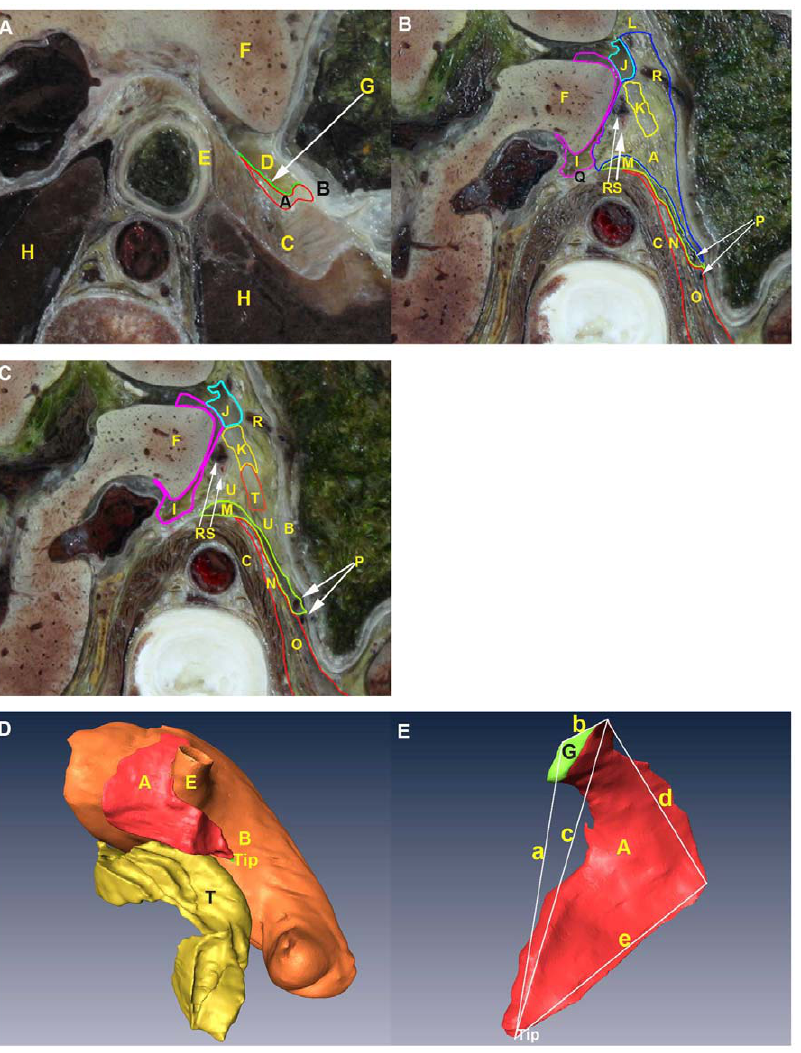
Figure 2. Visualization of the anatomy of the LES on CVH2. The LES is imaged on cross-sections from the inferior (A–C) and in 3D (D, E). (A) Starting cross-section of the LES. (B) Ending cross-section of the LES. On this section, the gastropancreatic ligament serves as the bottom margin of the LES. (C) Cross-section of the superior part of the pancreatic body. The appearance of the pancreatic body marks the disappearance of the LES; namely, the appearance of the peripancreatic space. (D) Posterointernal view of the spatial relationships of the LES to the stomach and pancreas. (E) Anteroexternal view of the LES. A: LES; B: gastric wall; C: left diaphragm; D: hepatogastric recess; E: distal esophagus; F: liver; G: upper segment of the left layer of the gastrophrenic ligament; H: lung; I: superior recess of the omental bursa; J: foramen bursae omenti majoris; K: inferior recess of the omental bursa; L: lesser omentum; M: gastropancreatic ligament; N: left retroperitoneal space; O: left adrenal gland; P: posterior gastric vein; Q: narrow space; R: left gastric vein and its branches; S: left gastric artery; T: pancreas; U: peripancreatic space; a: anterointernal leg; b: superior margin; c: diagonal line; d: posteroexternal leg; e: inferior margin.